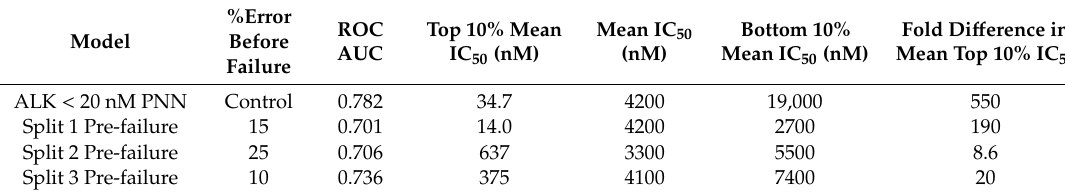
Table 8. Performance statistics for PNNs with retained predictivity generated with the specified error in each